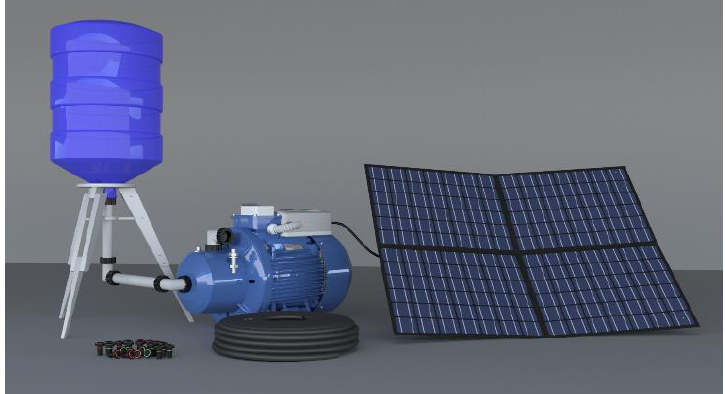
Figure 5. The purified water result: ( a ) Before treatment; ( b ) after treatment and the dead algae that was precipitated and ( c ) after getting rid of all algae precipitated in the bottom and the water became pure.